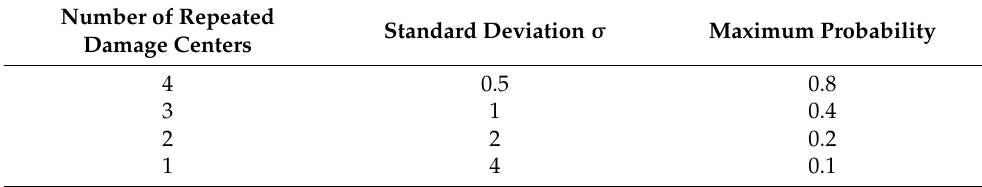
Table 4. Specified standard deviation for each number of repeated damage centers. Number of